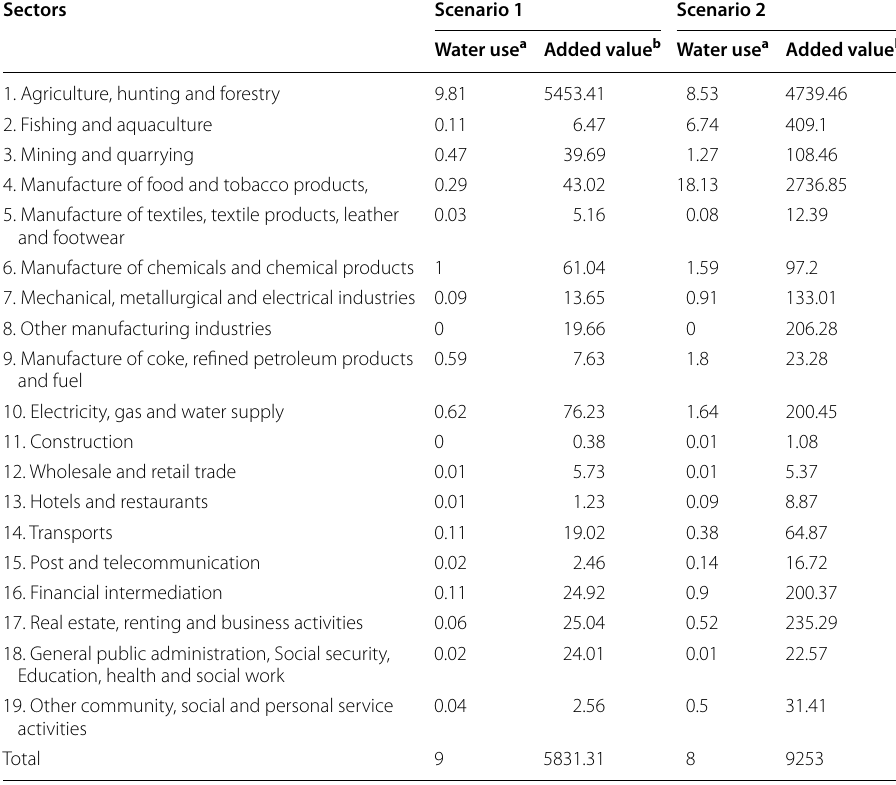
Table 3 Effects of an increase by 20% of the final demand in manufacture of food and tobacco